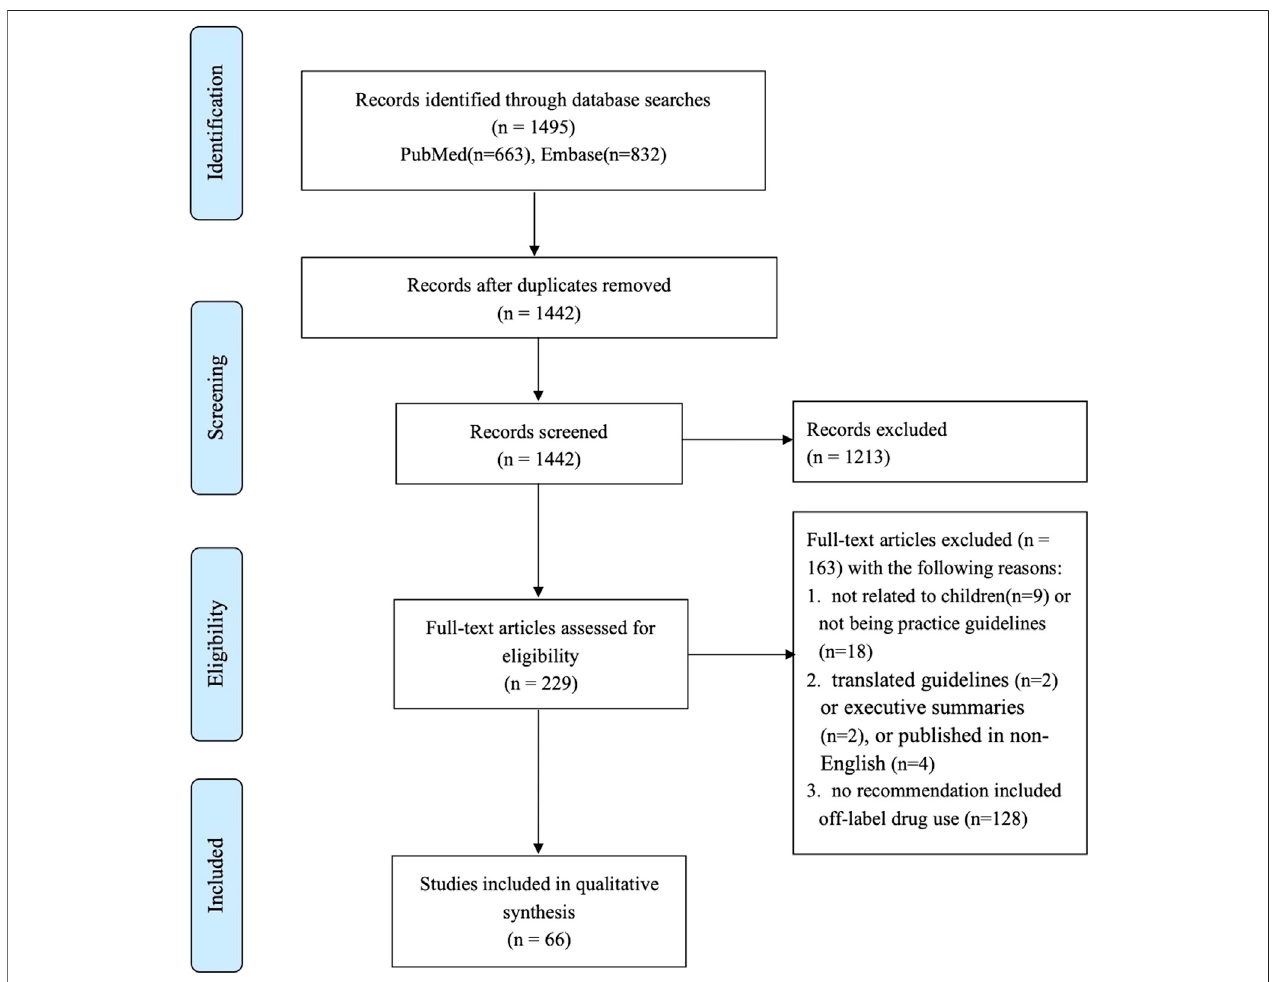
FIGURE 1 | Guideline screening